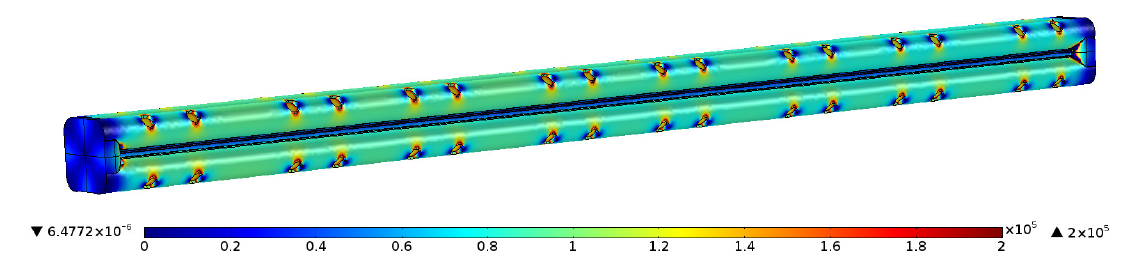
Figure 13. Peak power losses ( W / m 2 ) in the surface of the RFQ cavity, with all the tuners in uniform penetration. The model shown is a simplified model with no pumping pick-up ports included, but with modulation in full detail.